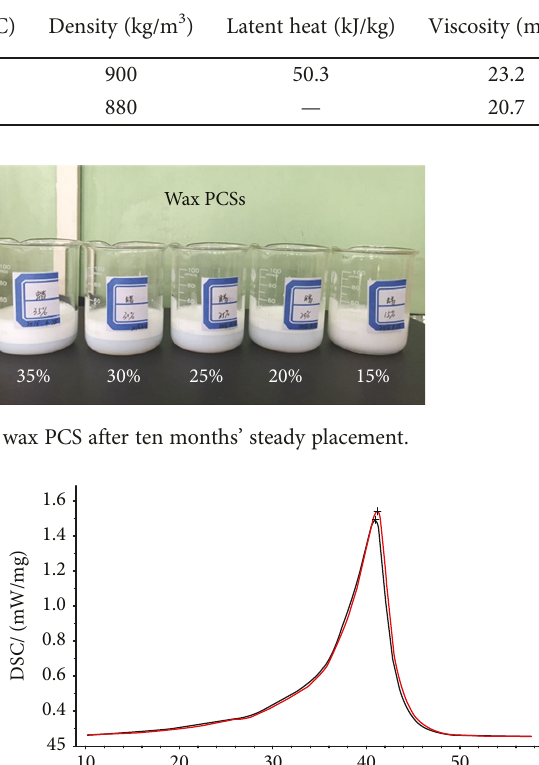
Table 2: Physical properties of PCS.